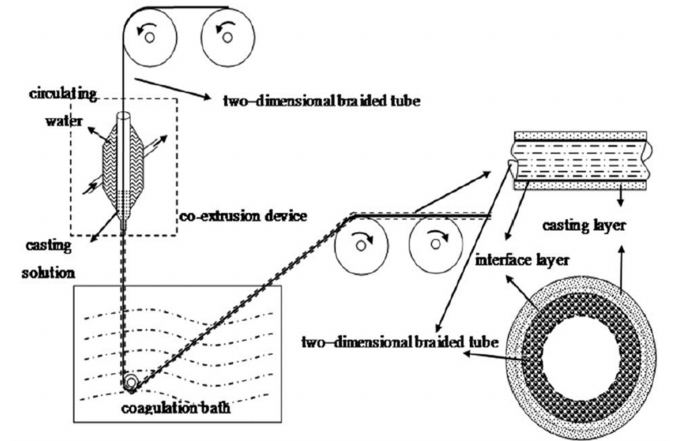
Figure 18. Schematic representation of braided tube reinforced two-dimensional PAN mem- brane [231]. Reprinted/adapted with permission from Ref. [231]. Copyright 2022, John Wiley and